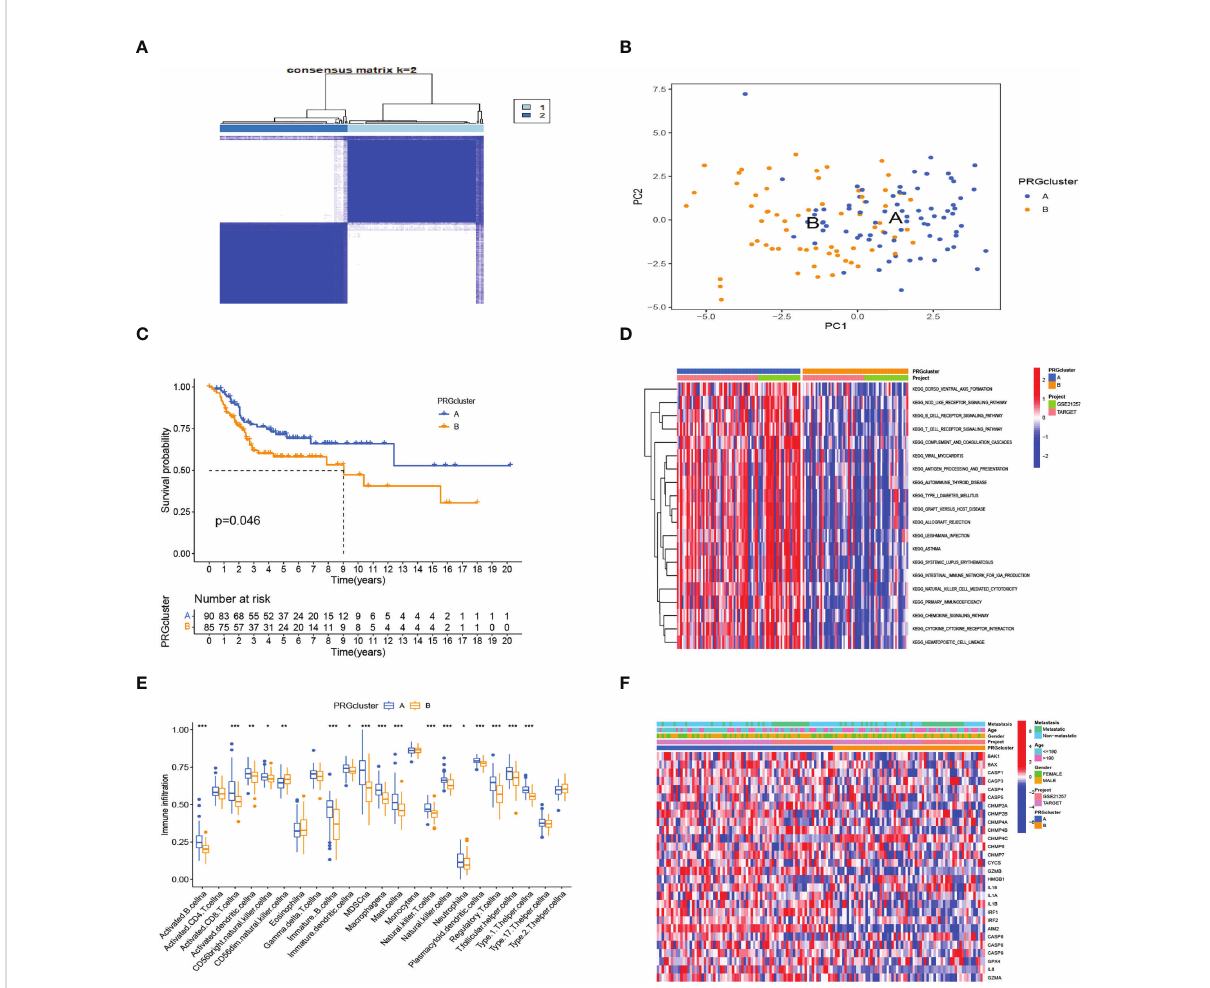
FIGURE 2 Subtypes of OS divided by pyroptosis-related regulators. (A) Consensus matrix heatmap de fi ning two clusters (k = 2) in the TARGET and GSE21257 cohorts. (B) PCA of the expression of PRGs indicating a signi fi cant difference between the two clusters. (C) Kaplan – Meier analysis showing the survival of the two clusters. (D) Differences in characteristics of clinicopathology and PRG expression levels among two clusters. (E) In the two subtypes, the tumor in fi ltration of 24 immune cell types. (***:p value <0.001, **:p value <0.01, *:p value <0.05) (F) The heatmap was used to depict the active biological pathways in different pyroptosis-related clusters, which were examined by GSVA. OS, osteosarcoma; PRGs, pyroptosis-related